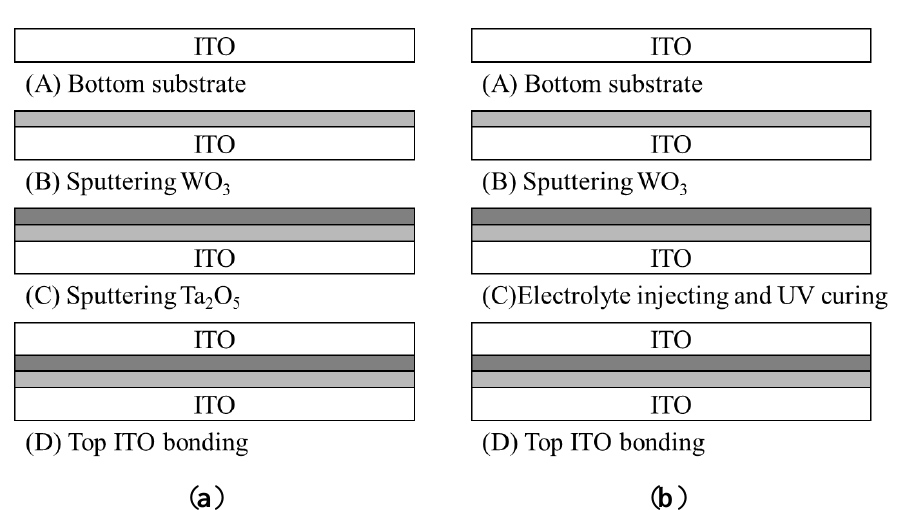
Figure 2. Overview of EC stack fabrication process: ( a ) ITO/WO ( b ) ITO/WO /lithium-polymer 3